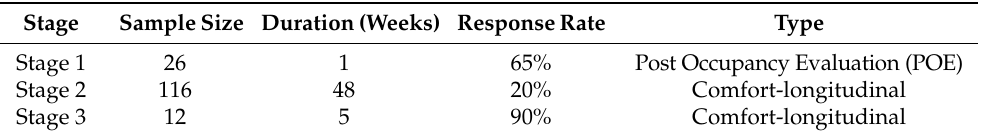
Table 3. Sample size and response rate at the different stages of the